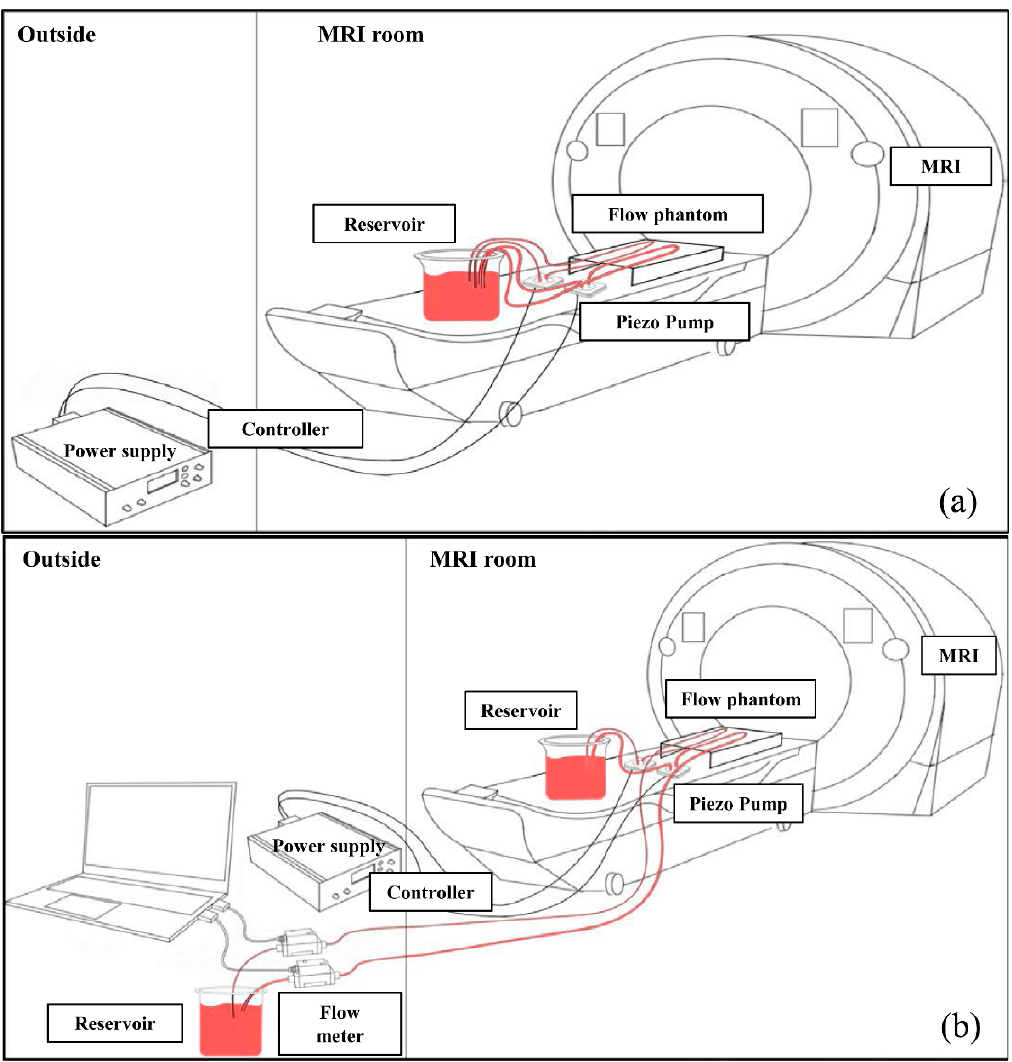
Figure 1. Flow system configuration using a 1 m tube ( a ) and a 6 m tube ( b ). ( a ) To confirm the structural shape of the microvascular phantom, the flow system was constructed by shortening the tube length to 1 m. ( b ) For flow velocities measurement, a flow system was connected by a 6 m tube to the flowmeter outside the MRI. Abbreviation: MRI, magnetic resonance imaging.